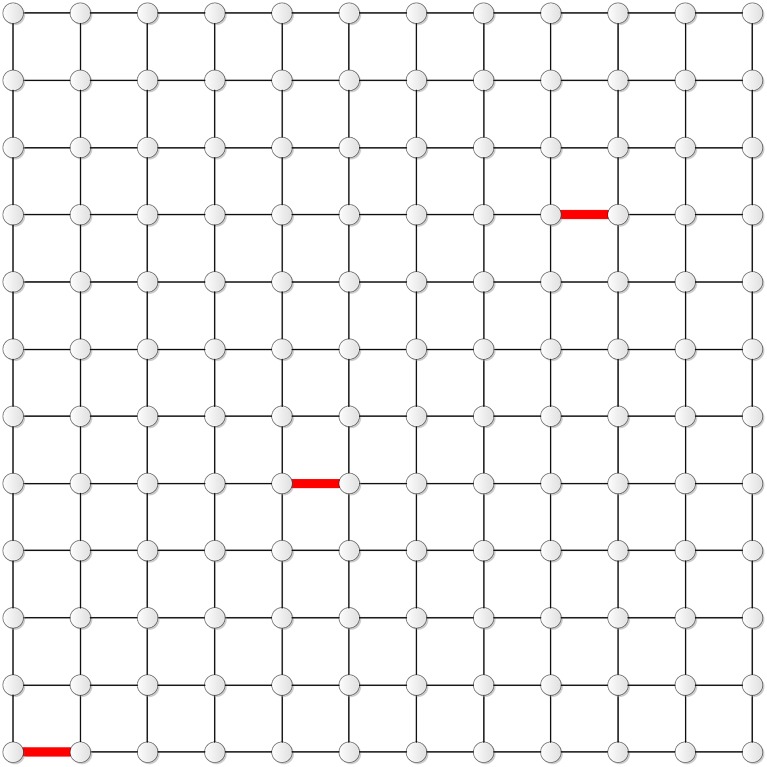
The distribution of the three edges in T12.